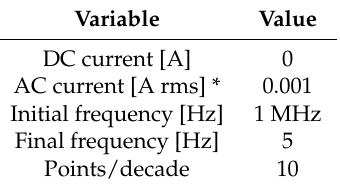
Table 3. Galvanostatic EIS settings for the potentiostat. * rms = root mean square, ≈ 0.7 × peak